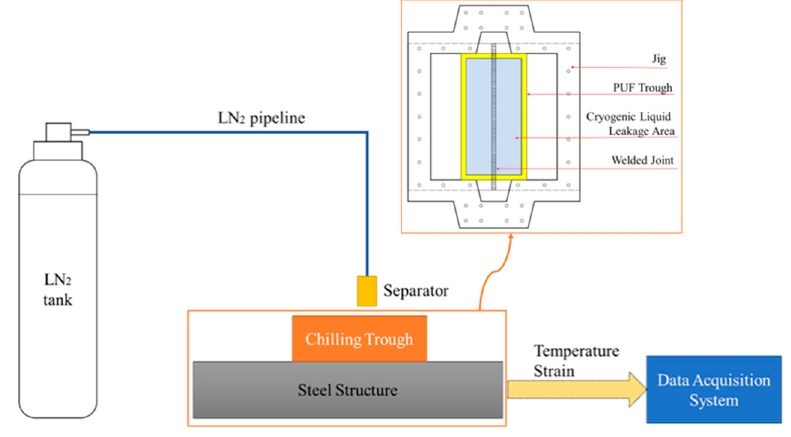
Figure 2. Schematic of the experimental setup of the cryogenic liquid leakage test.